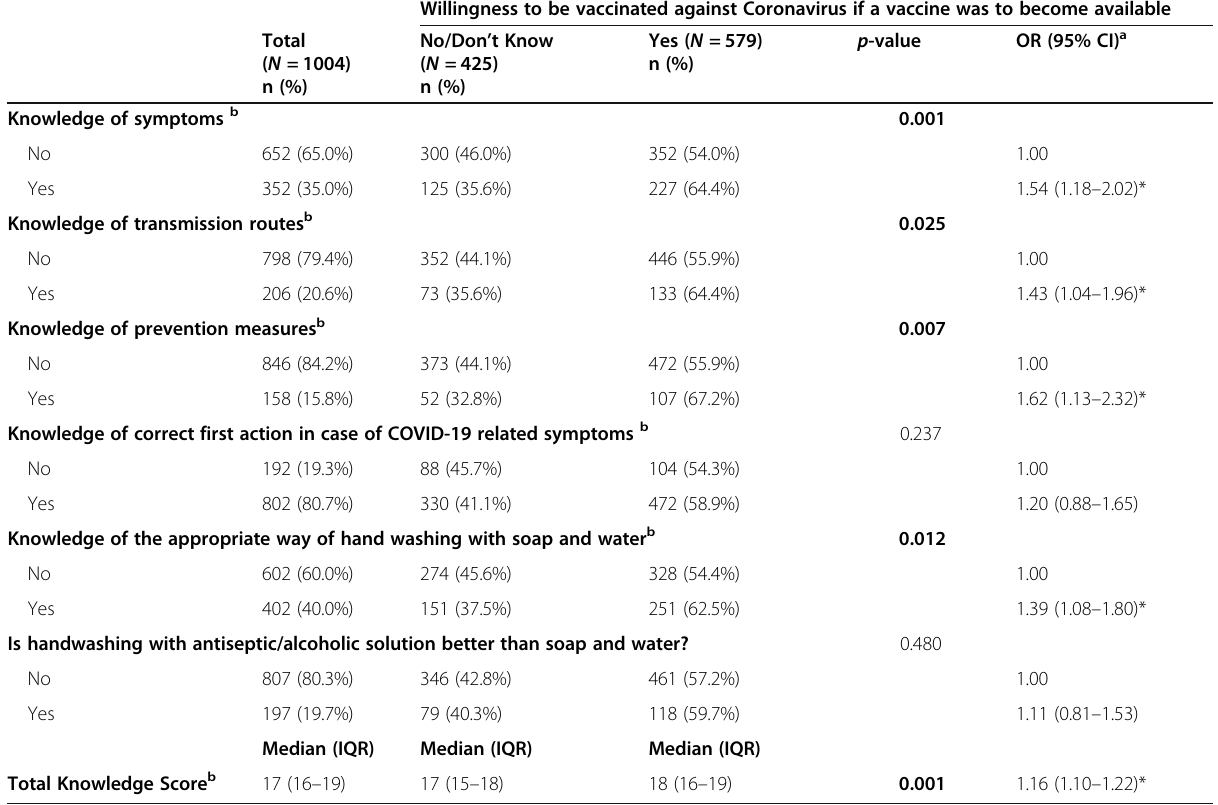
Table 2 Associations between knowledge against Corona Virus and willingness of respondents to get vaccinated for COVID-19 in Greece Willingness to be vaccinated against Coronavirus if a vaccine was to become available